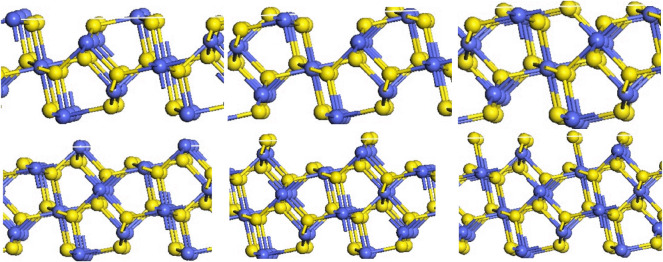
Different terminations of the CoS2 (210) surface.